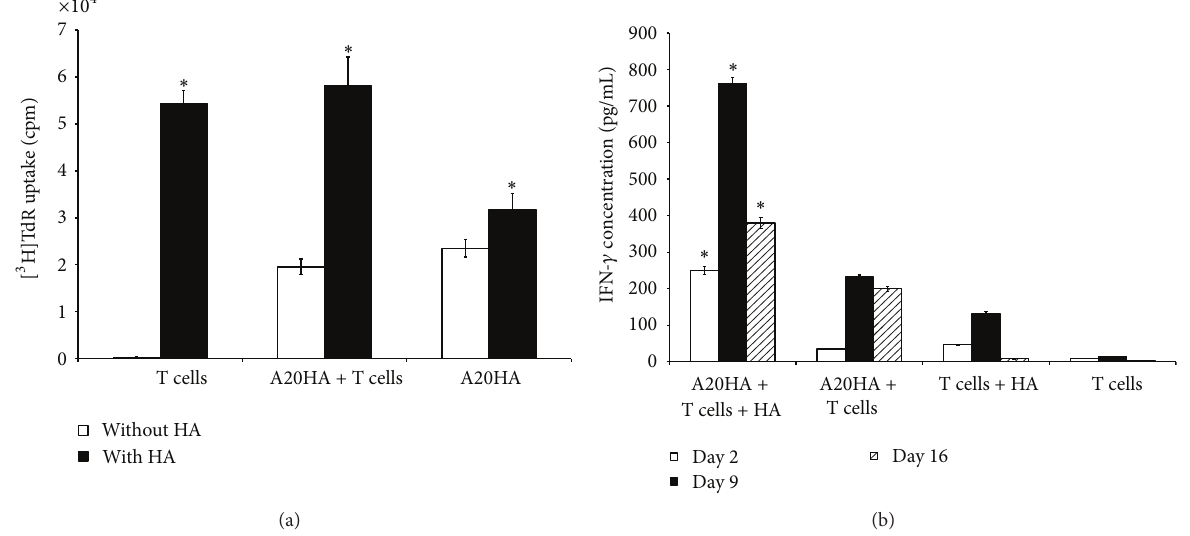
Figure 5: Proliferative response and production of IFN- 𝛾 by HA-specific CD4 + Thy1.1 + T cells from A20HA brain tumor-bearing mice demonstrate nonanergic status of a part the adoptively transferred Th cells. HA-specific CD4 + Thy1.1 + T cells were injected i.v. on day 5 after i.c. tumor inoculation into A20HA brain tumor-bearing mice (A20HA + T cells) and tumor-free control mice (T cells). A20HA brain tumor- bearing mice in the absence of HA-specific CD4 + Thy1.1 + T cells represented a negative control (A20HA). Spleens and cervical lymph nodes were pooled and analyzed after 72 h incubation with or without HA peptide in triplicates. (a) Proliferative response of HA-specific CD4 + T cells from spleens of A20HA brain tumor-bearing mice to restimulation in vitro with HA peptide is not reduced. Cell proliferation was measured by [ 3 H]TdR incorporation on day 16 after the adoptive transfer. (b) Production of IFN- 𝛾 by HA-specific CD4 + T cells from cervical lymph nodes of A20HA brain tumor-bearing mice induced by restimulation in vitro with HA peptide is maximal on day 9 and reduced on day 16 after the adoptive transfer. IFN- 𝛾 concentration was measured by ELISA. Data are represented as the mean ± SD, 𝑛 = 3 . ∗ 𝑃 < 0.05 .